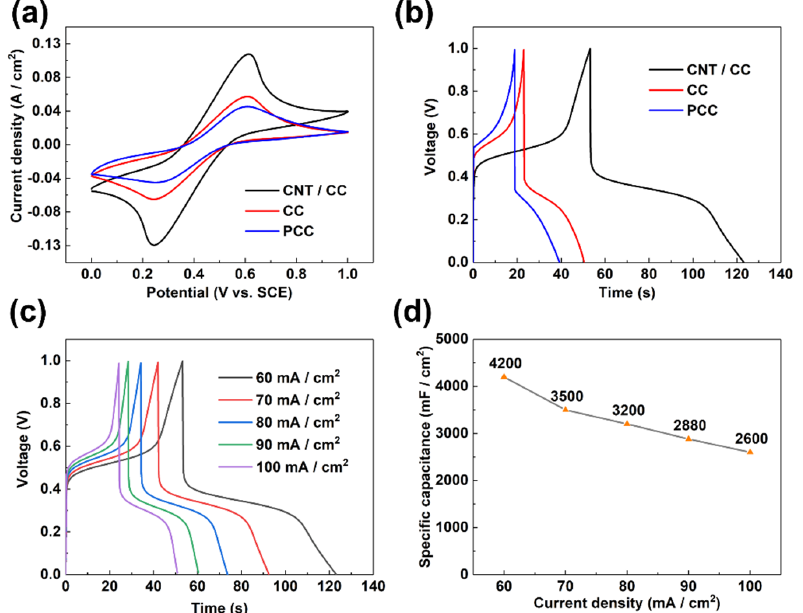
Figure 6. The electrochemical behavior of PCC, CC, and CNT/CC electrodes in 0.2 M Fe 2+/3+ + 1 M H 2 SO 4 electrolyte. ( a ) CV curves of PCC, CC, and CNT/CC electrodes at 10 mV/s; ( b ) GCD curves of PCC, CC, and CNT/CC electrodes at 60 mA/cm 2 ; ( c ) GCD curves of CNT/CC electrode at various current densities; and ( d ) the specific capacitance of CNT/CC electrode at various current densities.